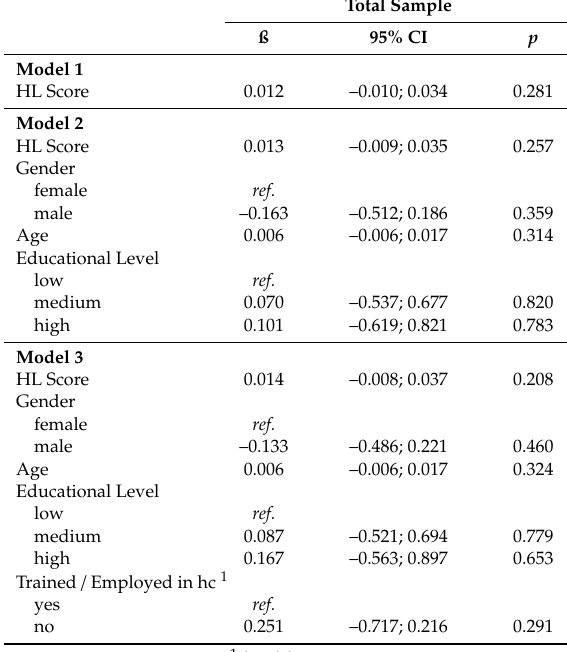
Table 4. Associations for total active transport as the dependent variable and HL as the independent variable, adjusted for gender, age, educational level, and training / employment in